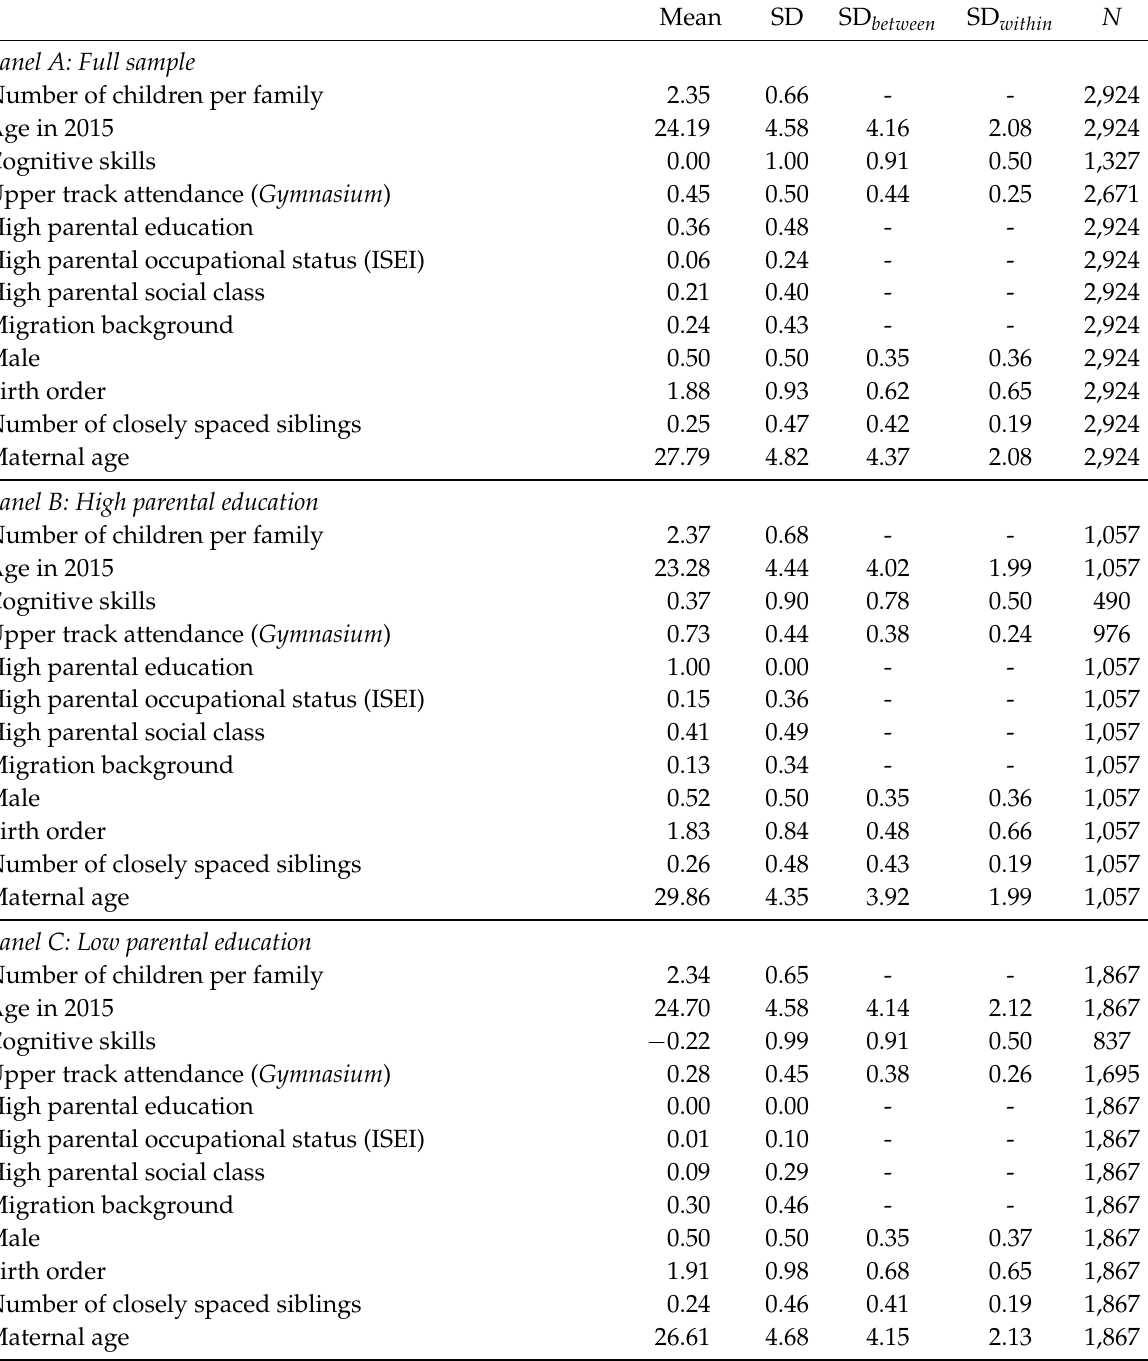
Table 1: Descriptive